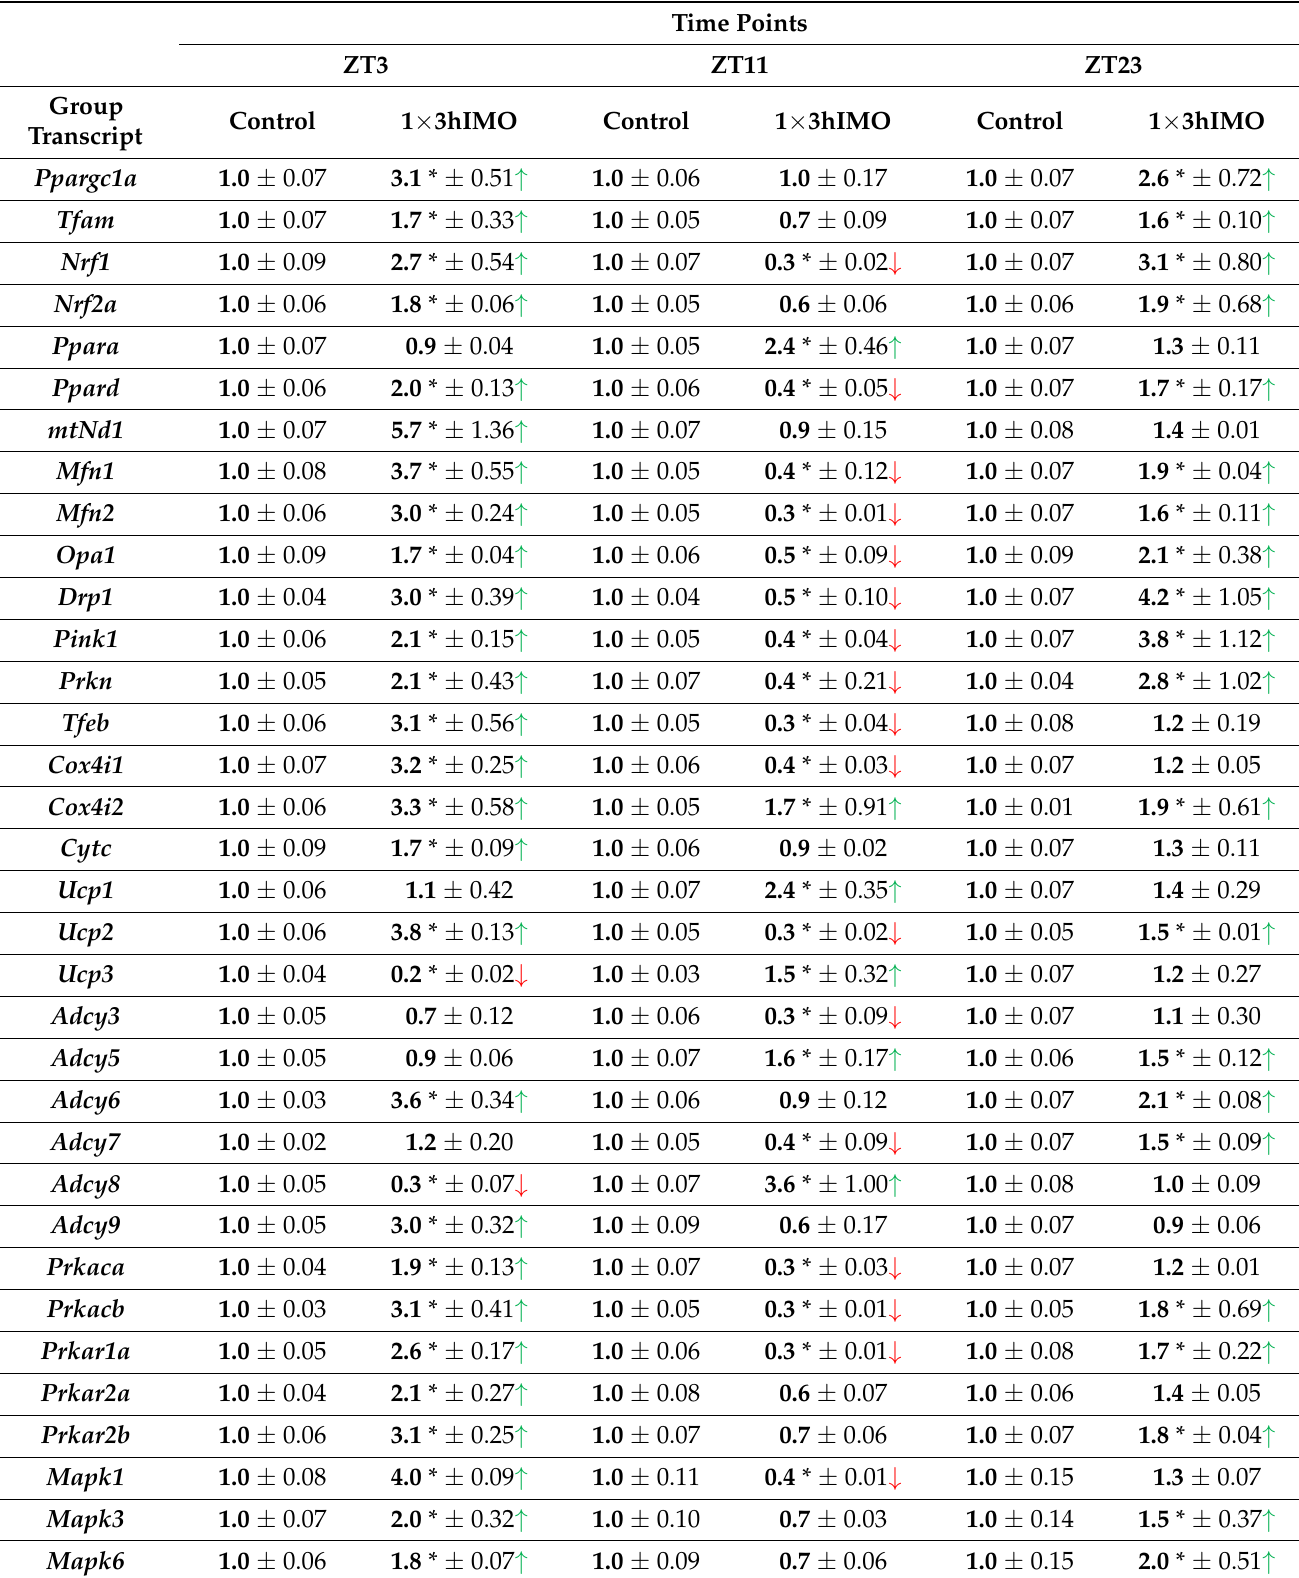
Table 1. Transcriptional profiles of mitochondrial dynamics and functionality markers and signaling molecules regulating mitochondrial dynamics and functionality as well as spermatozoa number and functionality in spermatozoa of repeatedly stressed adult